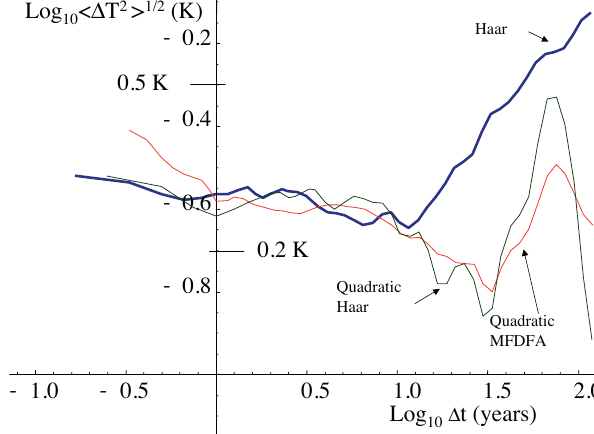
Fig. 10. A comparison of the different structure function analyses Fig. 11. The same temperature data as Fig. 10: a comparison of the (root- mean-square, RMS) applied to the ensemble of three monthly RMS Haar structure function (multiplied by 10 0 . 35 = 2.2), the RMS surface series (NASA GISS, NOAA CDC, HADCRUT3; see Love- quadratic Haar (multiplied by 10 0 . 15 = 1.4) and the RMS quadratic joy and Schertzer, 2012a), each globally and annually averaged, MFDFA (multiplied by 10 1 . 5 = 31.6). Reproduced from Lovejoy from 1880–2008 (1548 points each). The usual (difference, poor and Schertzer (2012a). man’s) structure function is shown (dotted, lower left), the ten- dency structure function (dot-dashed, lower right), the maximum of the two (“hybrid”, thick, red), and the Haar in blue (as indi- cated); it has been increased by a factor C = 10 0 . 35 = 2 . 2, and the RMS deviation with respect to the hybrid is ± 14%. Reference slopes with exponents ξ( 2 )/ 2 ≈ 0.4, − 0.1 are also shown (black corresponding to spectral exponents β = 1 + ξ( 2 ) = 1.8, 0.8, respec- tively). In terms of difference fluctuations, we can use the global D E 1 / 2 1T (1t) 2 root-mean-square annual structure functions (fitted D E 1 / 2 ≈ 0 . 08 1t 0 . 33 1T (1t) 2 for 129yr >1t > 10yr), obtaining for the ensemble. In comparison, Lovejoy and Schertzer (1986) D E 1 / 2 ≈ 0.077 1t 0 . 4 using Northern 1T (1t) 2 found the very similar Hemisphere data (these correspond to β c = 1.66, 1.8 respectively).